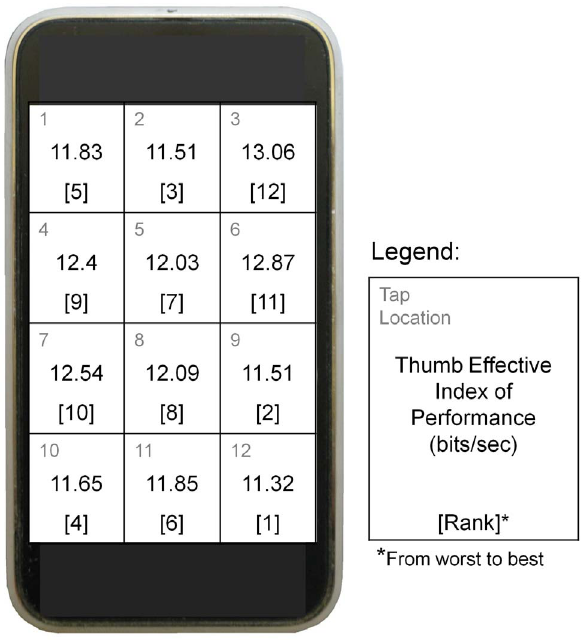
Figure 2. Average values for effective index of thumb performance (bits/sec) and their rank for each tap location determined by Trudeau et al., 2012b, used in the calculation of the tap location performance index (adapted from Trudeau et al., 2012b).